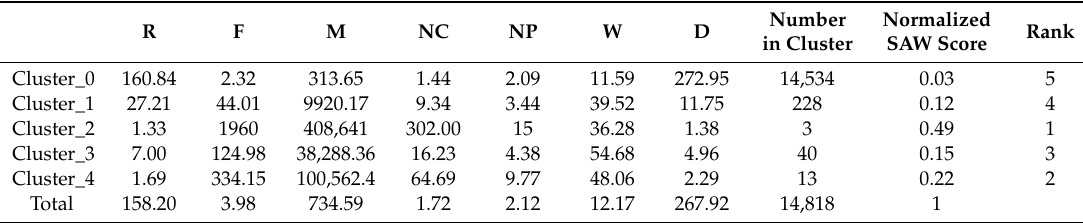
Table 6. Clustering of 14,818 clothes shippers using Recency, Frequency, and Monetary Concept (RFM) variables.